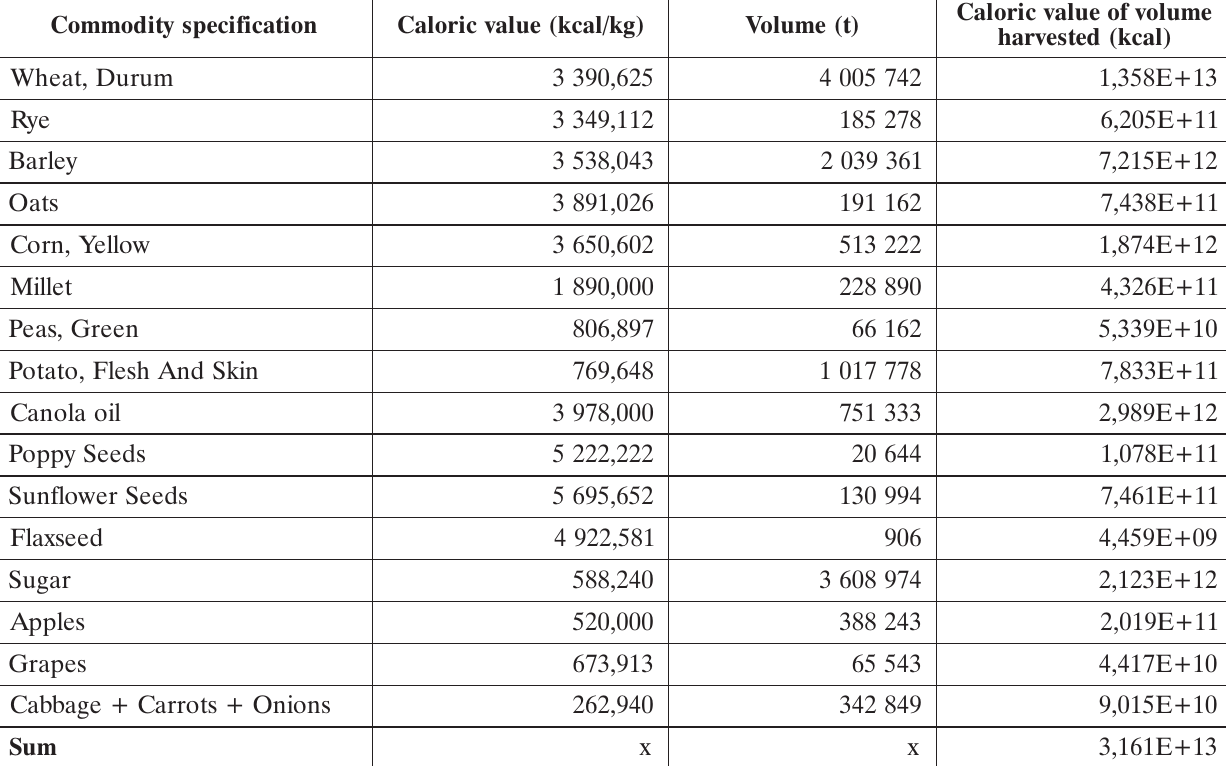
Table 4. Crop Output Total in calories